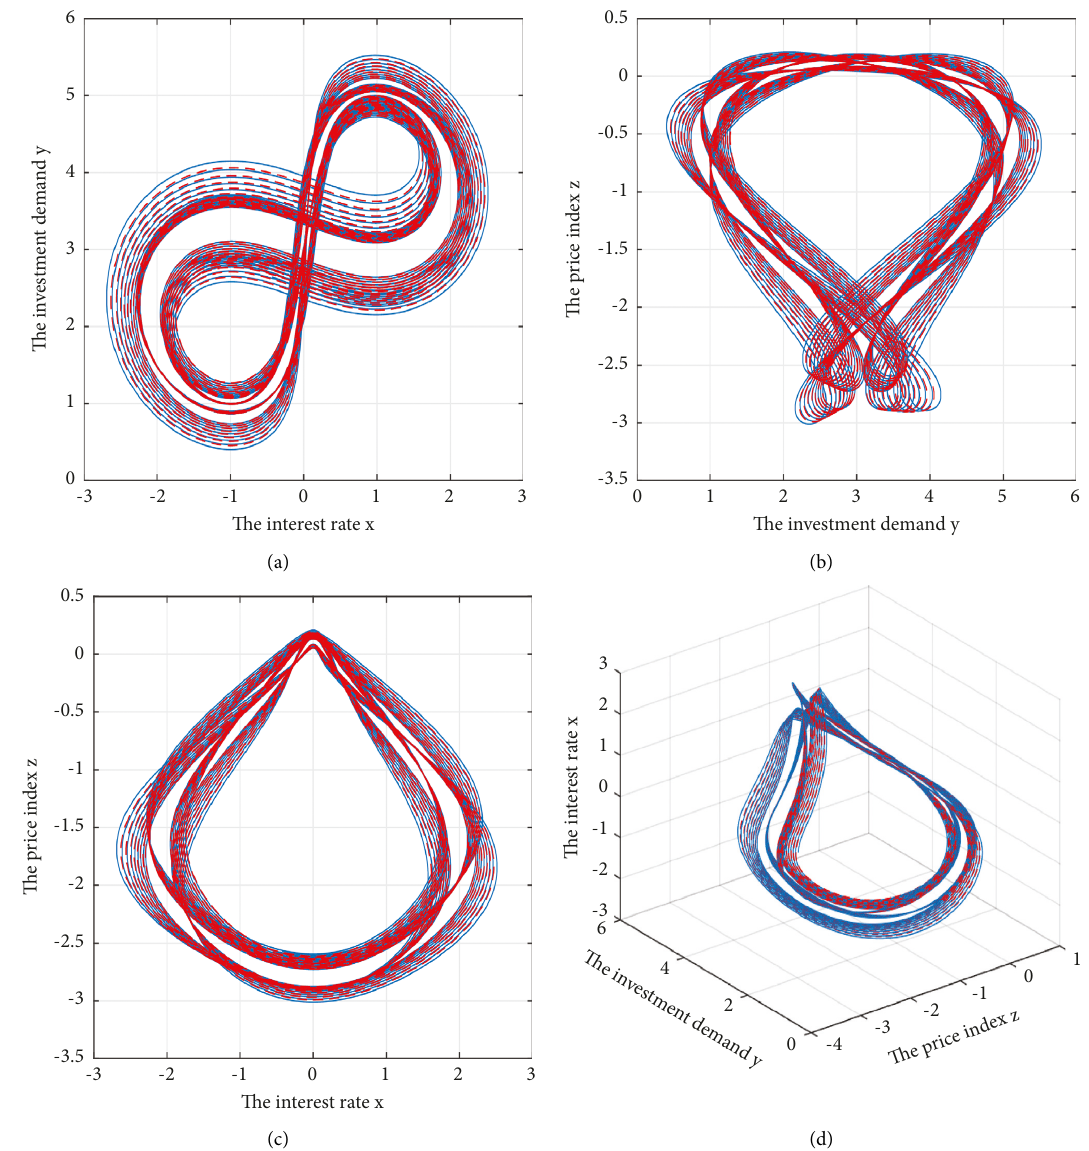
Figure 4: The phase portrait of the proposed model where (a) the demand of investment versus the rate of investment, (b) the index of the price versus the demand of investment, (c) the index of price versus the rate of investment, and (d) the chaotic behaviour of the system with the input parameter a � 0 . 3 ,b � 0 . 1, and c � 3 to identify the influence of these input parameters on the chaos of the